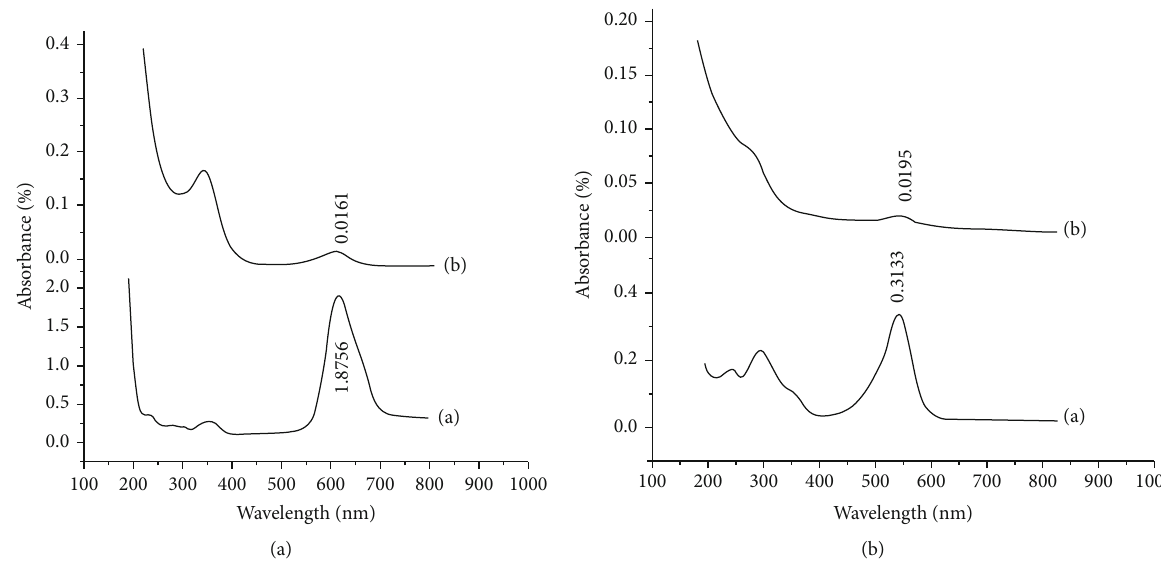
Figure 4: (i) UV-vis spectrum of BG4 dye and (ii) AF dye before and after adsorption.